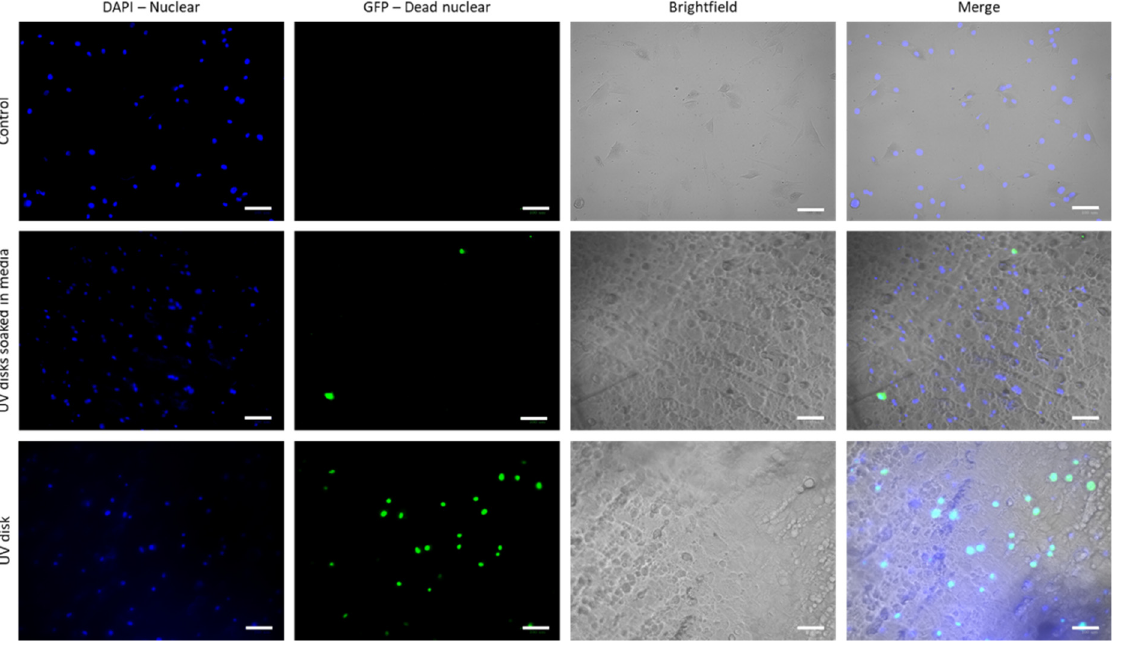
media-soaked disks for 2 h and 48 h, respectively, and 2 h UV-sterilized disks only. Staining was carried out according to the manufacturer’s guidelines for 30 min and plates were centrifuged before